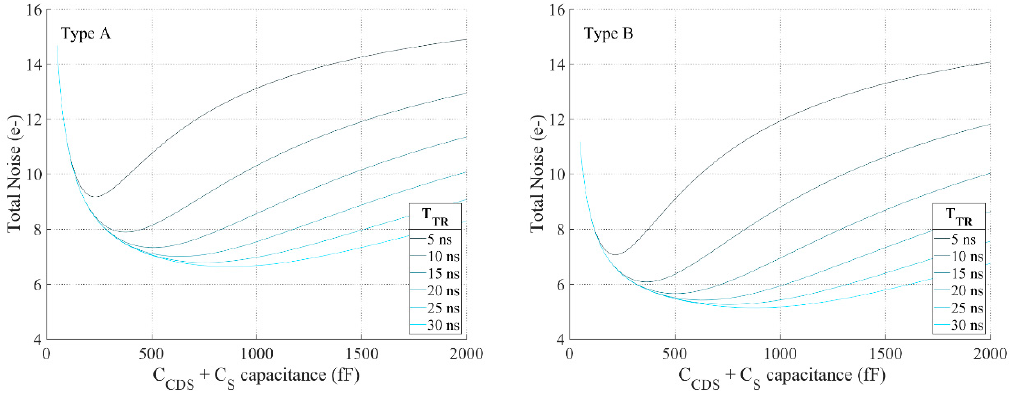
Figure 9. The input referred noise against sum of C CDS and C S w.r.t to different tracking time (15 ns settling time is targeted for 20 Mfps operation). Left : Type A. Right : Type B. The C CDS and C S are chosen according to the optimal ratio based on Equations (7) and (9).